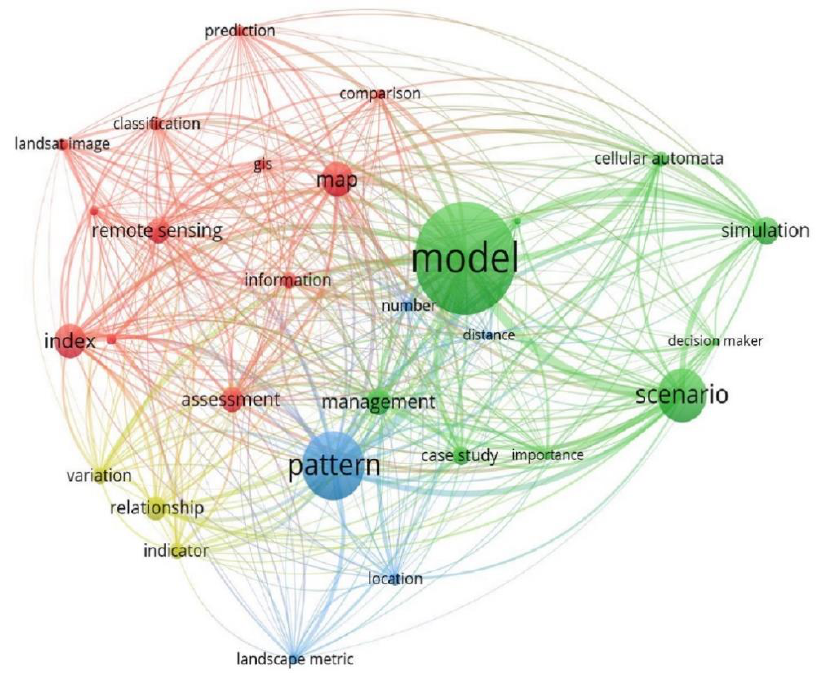
Figure 3. Primary codes (factors driving LULCC) found in the 451 selected records by abstract.